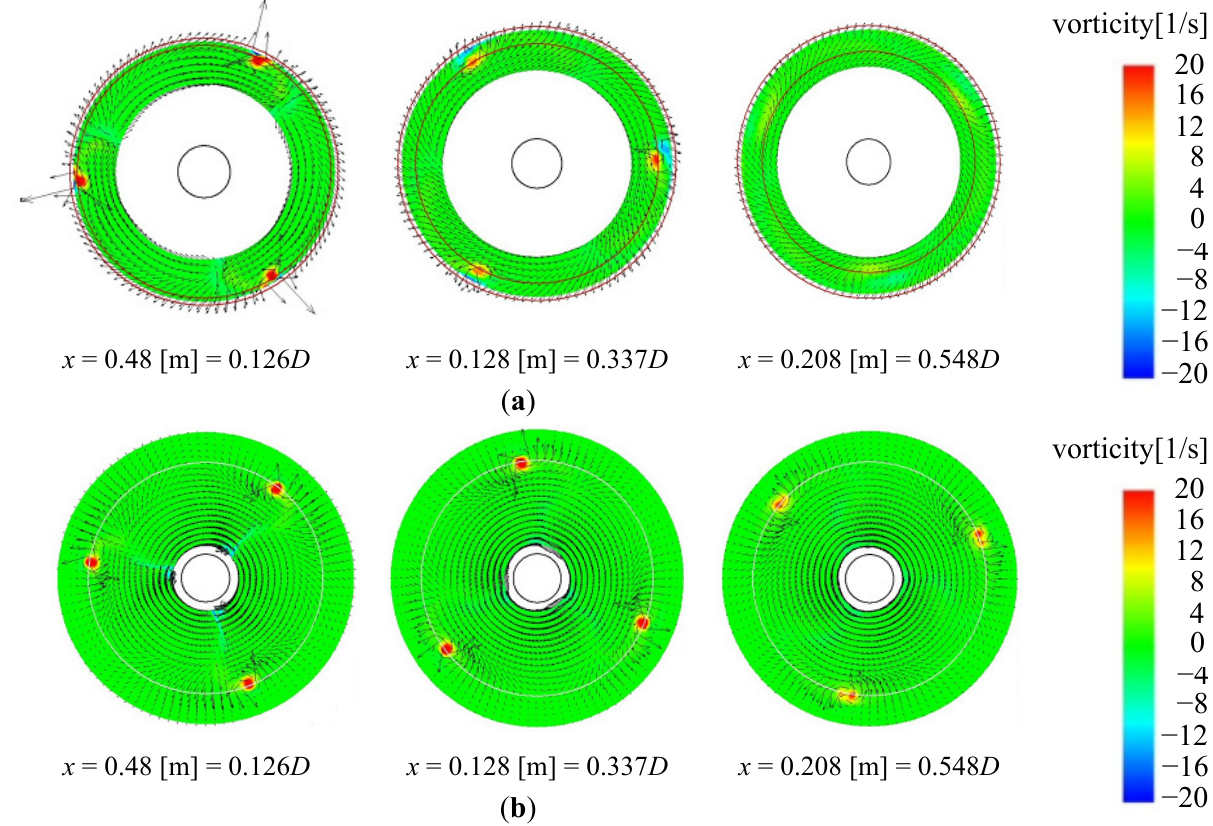
Figure 10. ( a ) Wind tunnel experimental results for the long-type Wind-Lens turbine: x -component of the vorticity (colors) and velocity (vectors) in r - θ cross-sections; ( b ) Same as Figure 10a except for the bare wind turbine